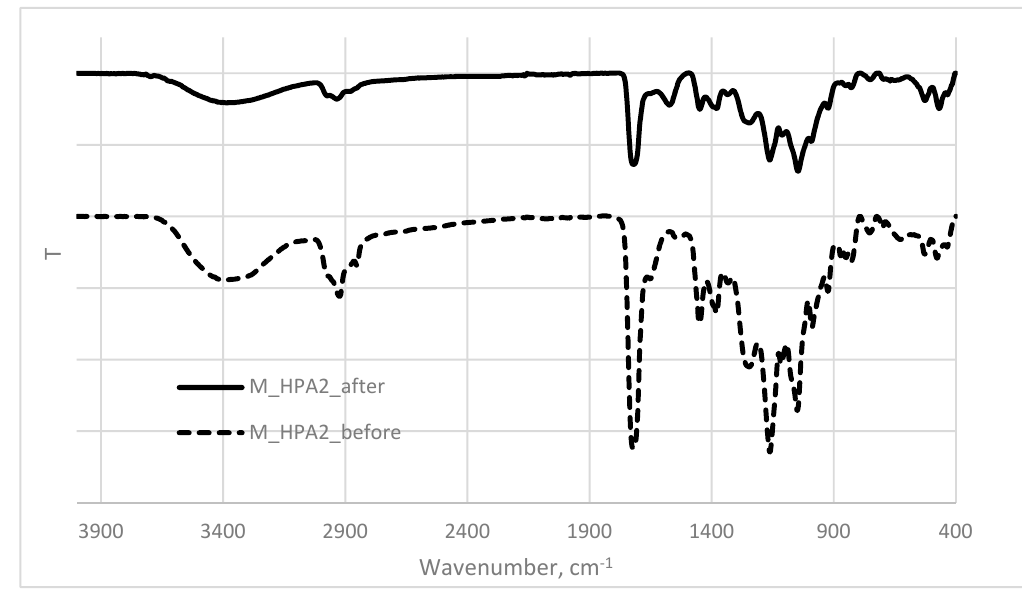
Figure 5. The superimposed FTIR spectra of the glycopolymer sample before and after biodegradation.